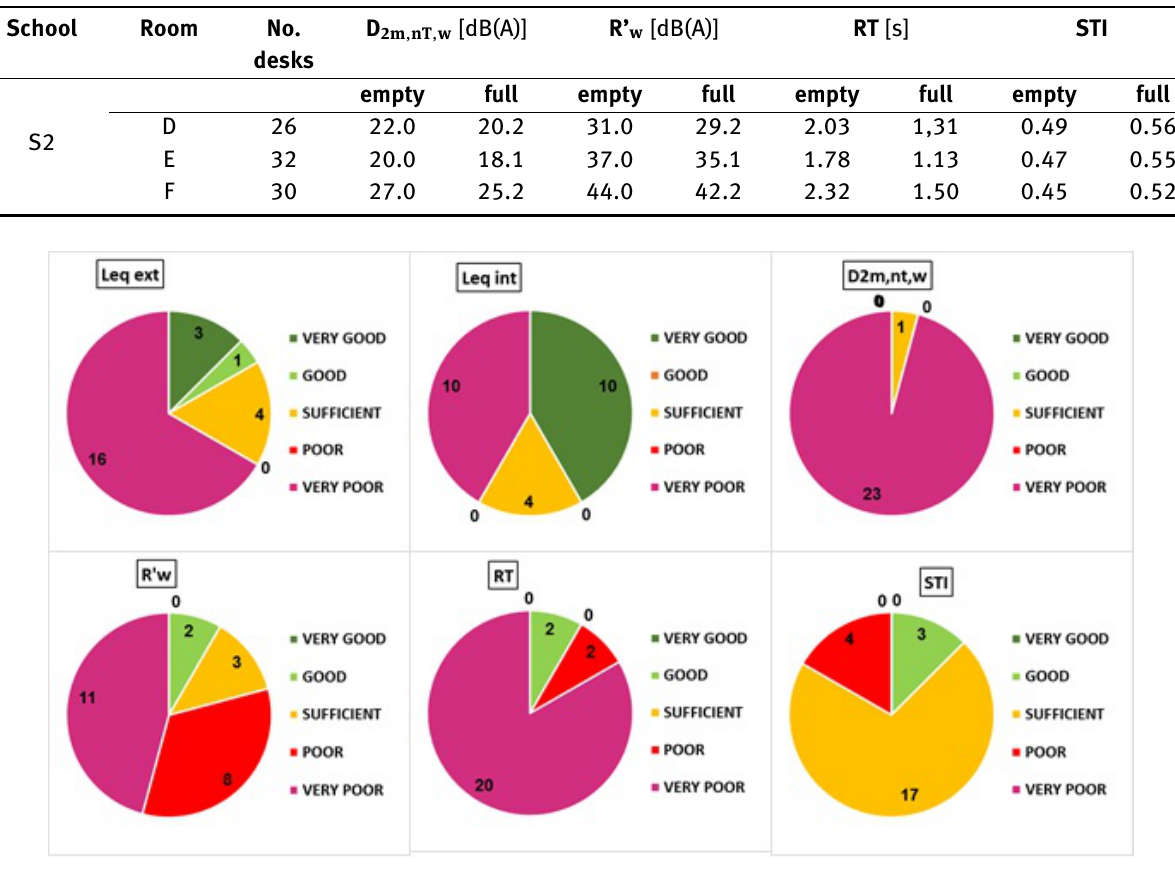
Figure 6: Details of single parameters evaluation.